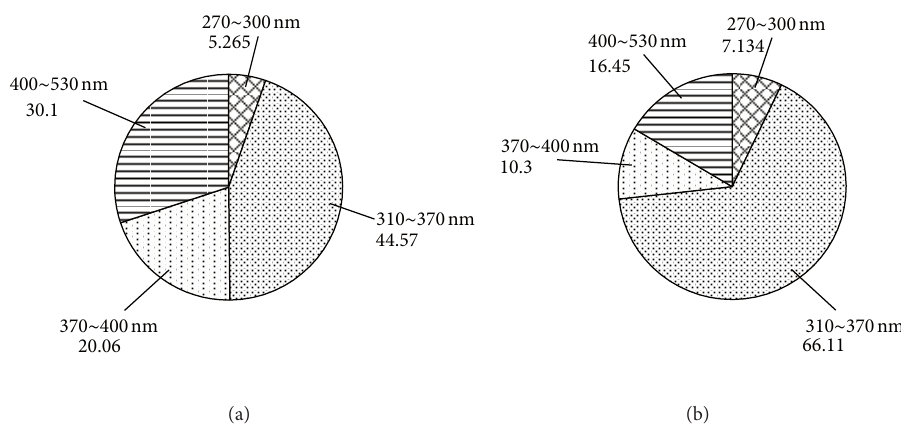
F 2: Pie chart of synchronous �uorescence spectra for (a) river water and (b) ��TP